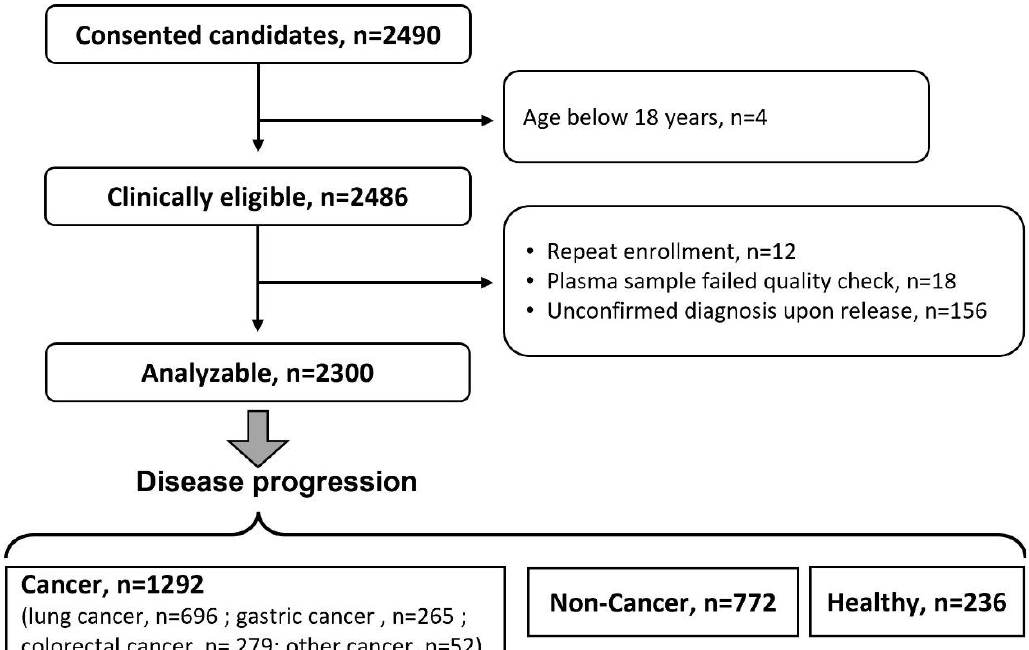
Figure 3. Flow chart of the patient disposition in the cancer pilot study. A total of 190 were excluded by either meeting one of the exclusion criteria or failing the sample quality check, and 1292, 772, and 236 patients were enrolled in the cancer, non-cancer and healthy group,